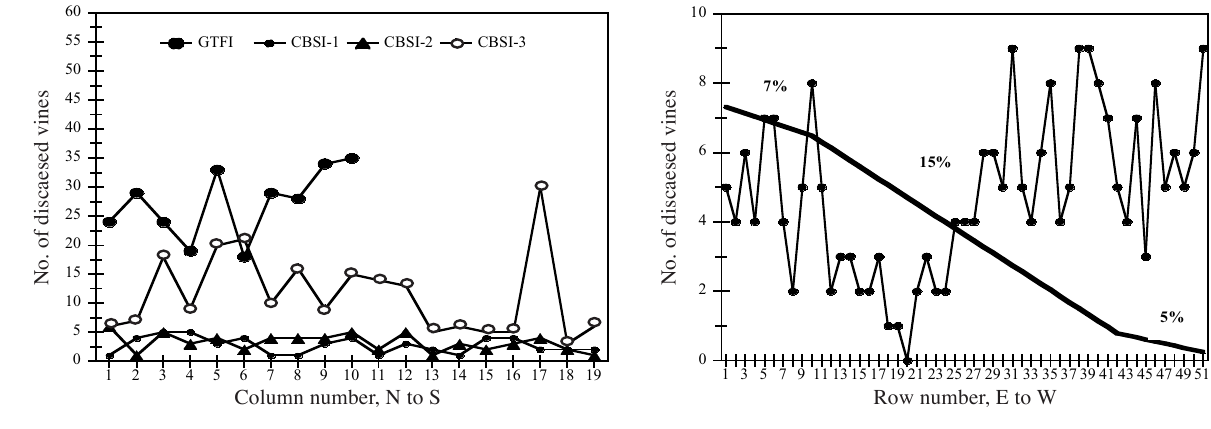
Fig. 10. Number of diseased vines in each row of a vine- yard at Gambassi Terme. The slope (%) of the vineyard is also